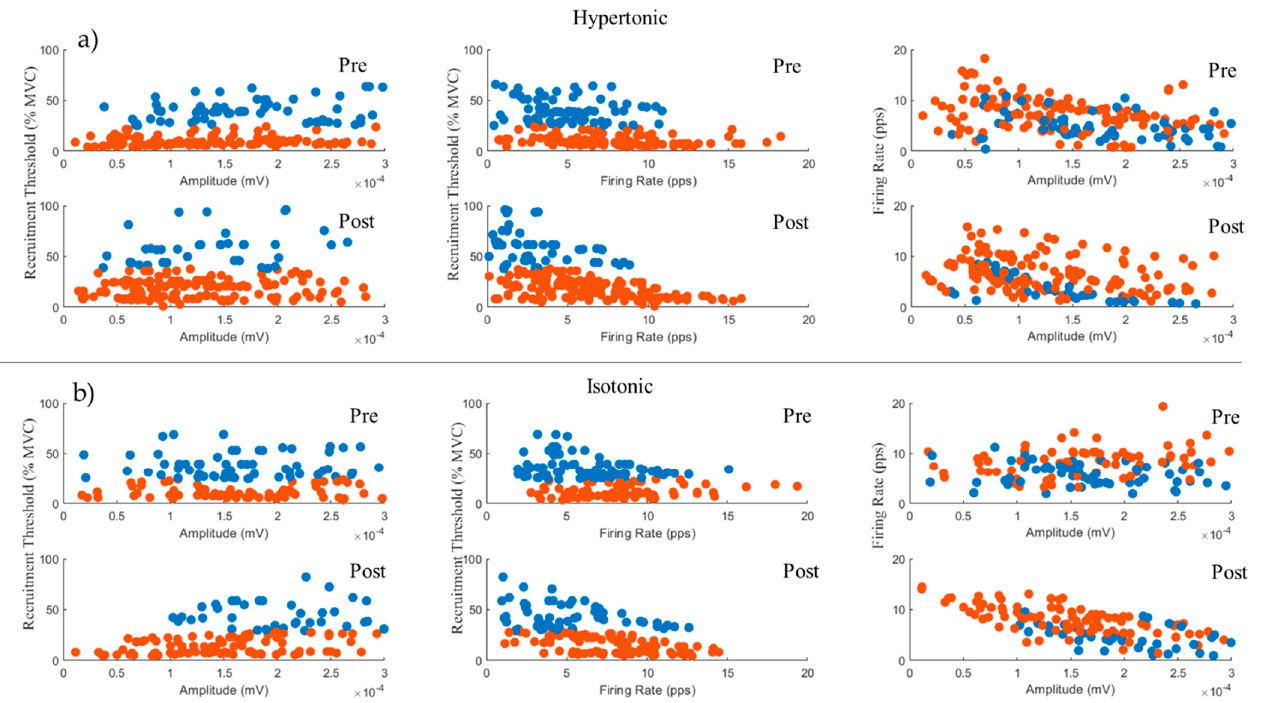
Figure 3. Two-dimensional plots of the 3 variables considered in the clustering analyses. ( a ) Clusters of MUs during induced muscle pain in each epoch. ( b ) Clusters of MUs during placebo protocol in each epoch. Each point represents a motor unit, identified as belonging to group 1 (red) or 2 (blue), according to the recruitment threshold value. Pre- and post-injection values are shown.